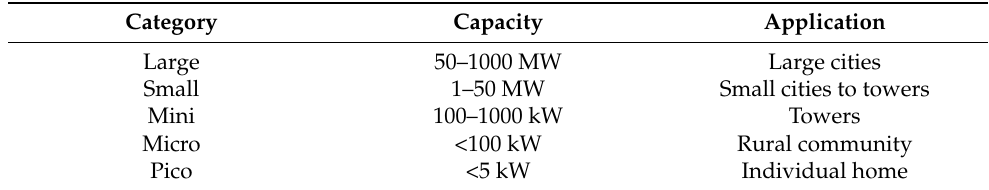
Table 1. The hydraulic power plant categories [42,45,46].